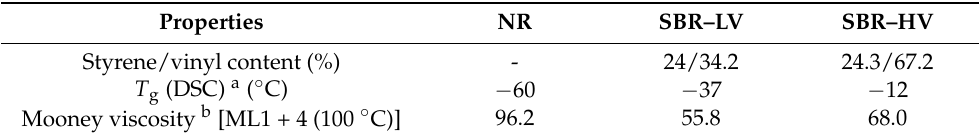
Table 1. Characteristics of the pure